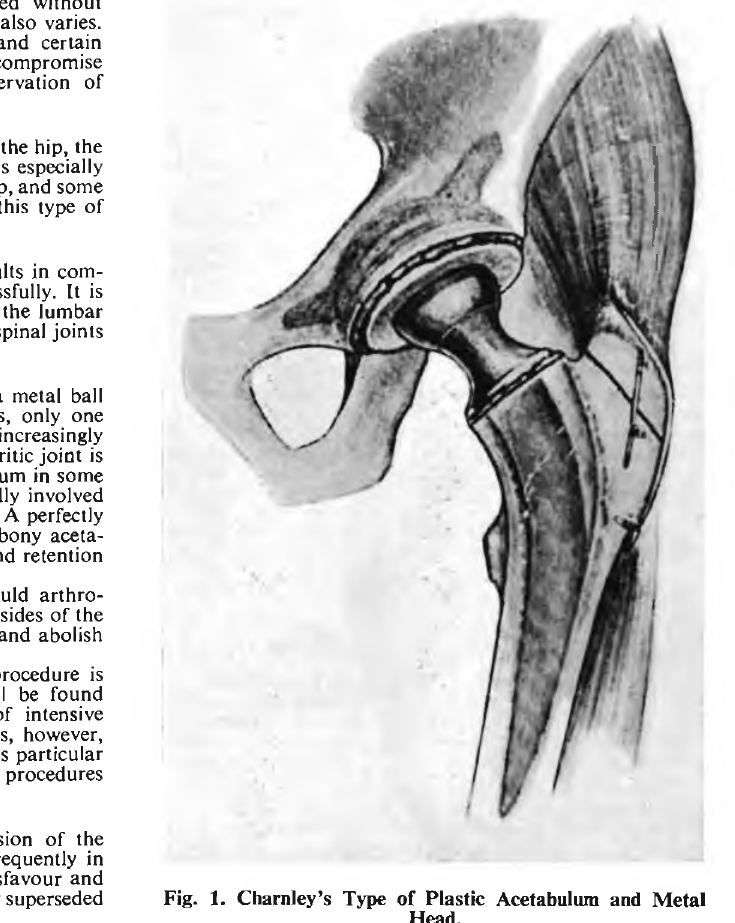
Fig. 1. Charnley’s Type of Plastic Acetabulum and Metal